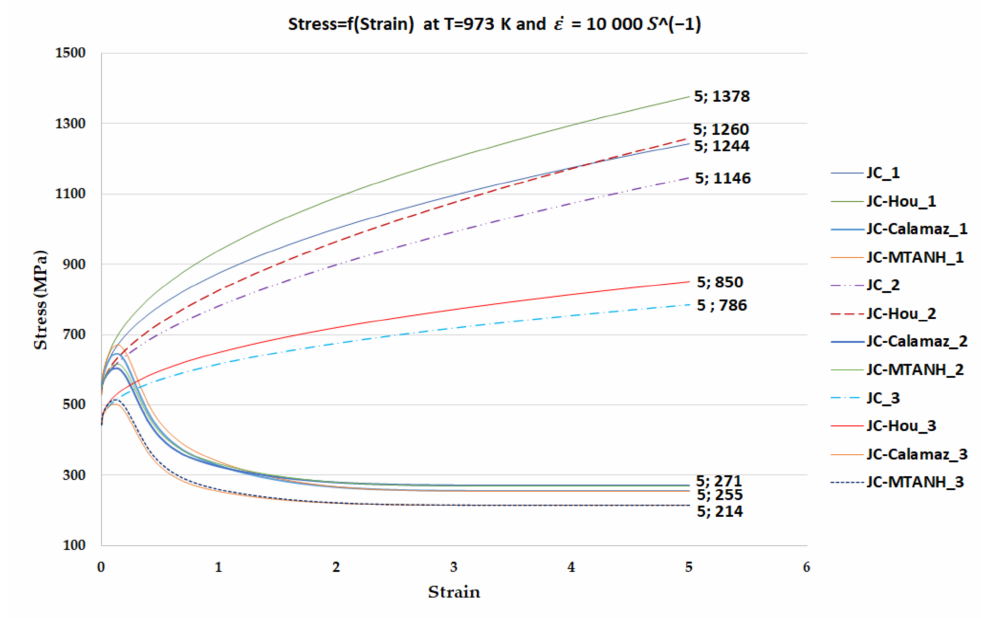
Figure 2. Stress-strain curves of JC, JC-Hou, JC-Calamaz and JC-MTANH for 3 sets of parameters at . T = 973 K and ε 0 = 10,000 s − 1